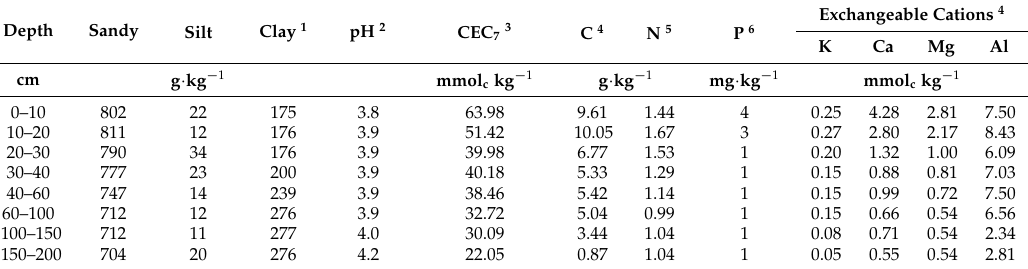
Table 1. Physical and chemical attributes of experimental site